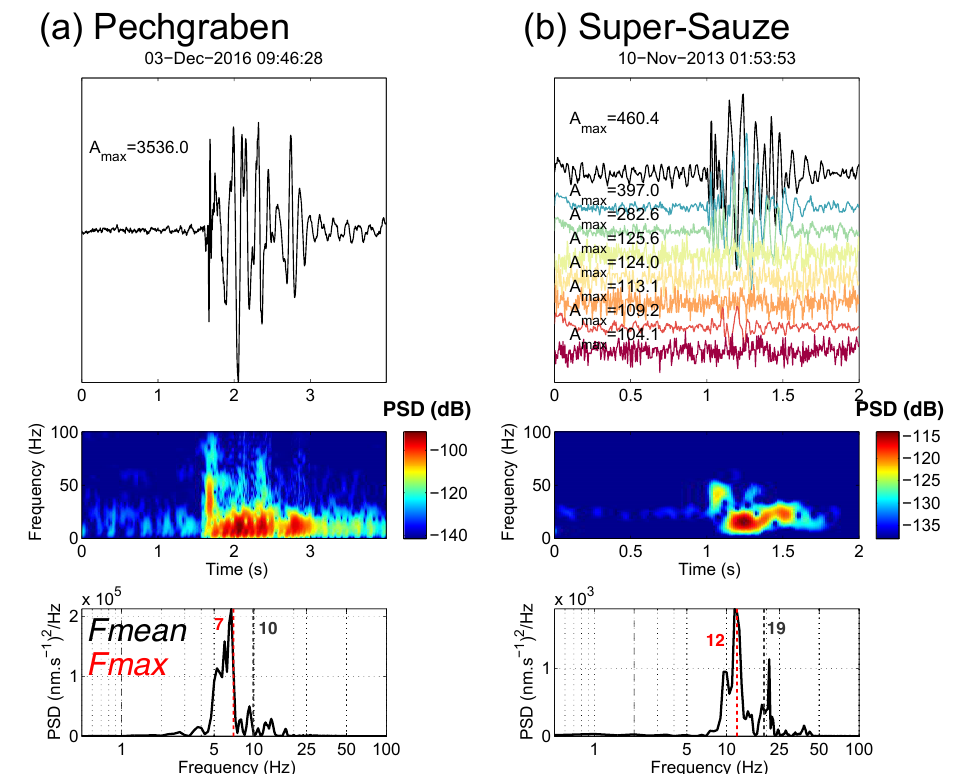
Figure 8. Hybrid slopequake recorded at the (a) Pechgraben and (b) Super-Sauze landslide. See Fig. 2 for a description of the figure.